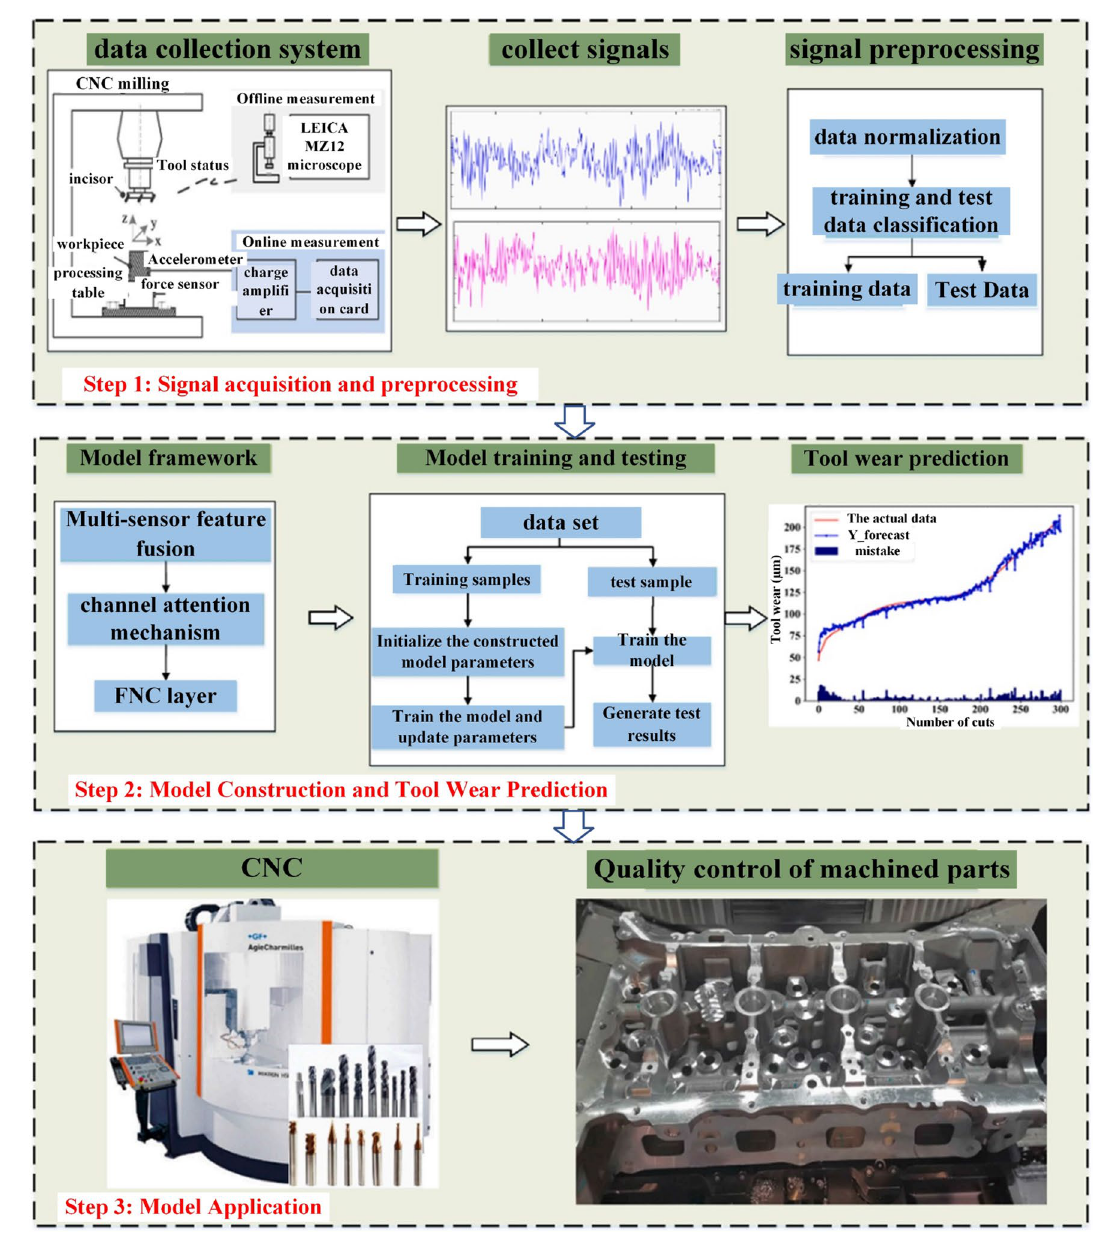
Fig. 11 Tool wear prediction process based on data-driven technology